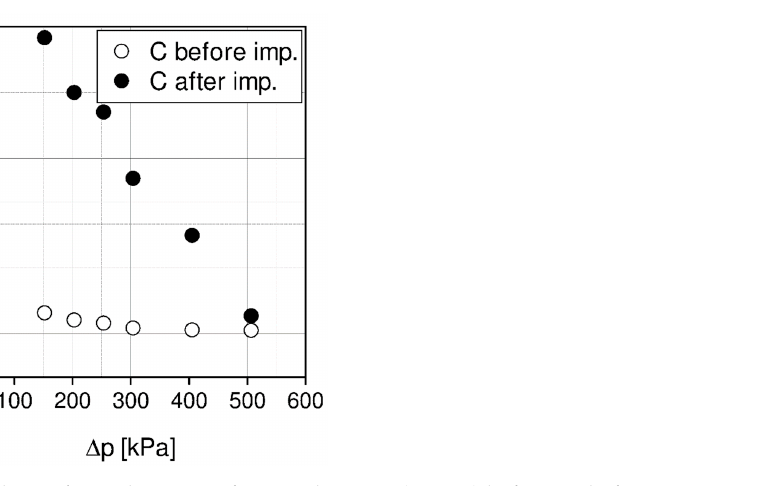
Figure 9. Ideal CO 2 /N 2 selectivities for membrane C (PDMS) before and after impregnation with [Emin][Ac], temperature 20